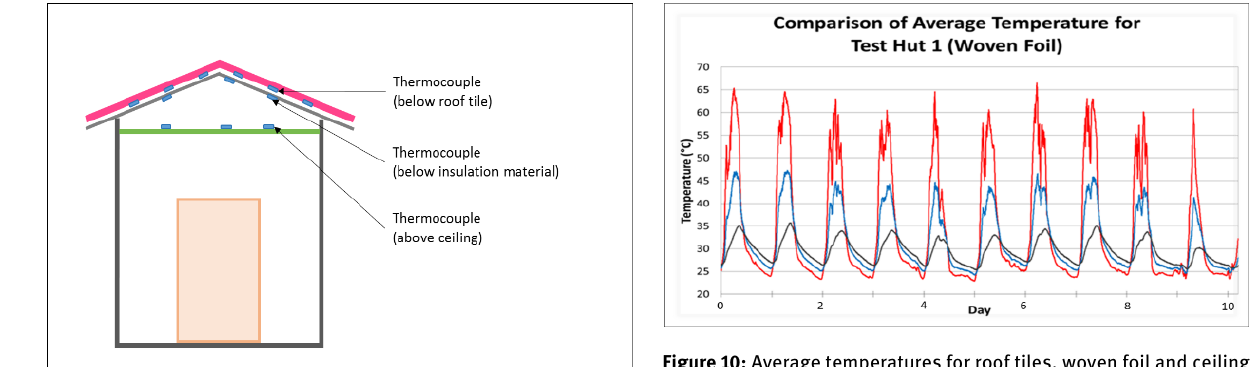
Figure 10: Average temperatures for roof tiles, woven foil and ceiling It is noted that the ceiling temperatures for Test Hut 1 and Test Hut 3 are significantly lower than Test Hut 2 dur- ing day time. RSI t is the total thermal resistance of two en- closed regions of the attic as indicated by Equation (7). The heat fluxes for the upper attic region were obtained from the transducer mounted on the ceiling using Equation (8). RSI block is then calculated by averaging temperature and heat flux data for ten two-minute intervals, as expressed in Equation (9). For instance, if there are 1,000 two-minute intervals, then there will be 100 RSI block